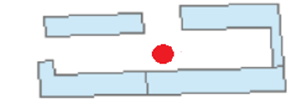
Figure 3. Wrong judgment of bounding